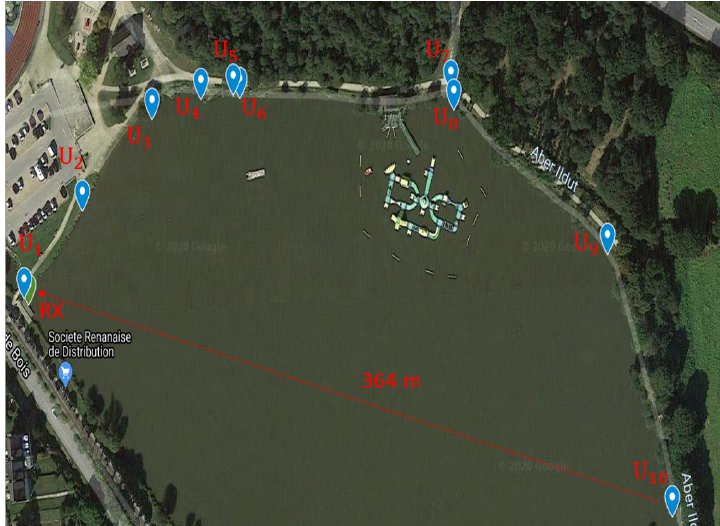
Figure 9. Experiment scheme on the Ty-Colo lake of